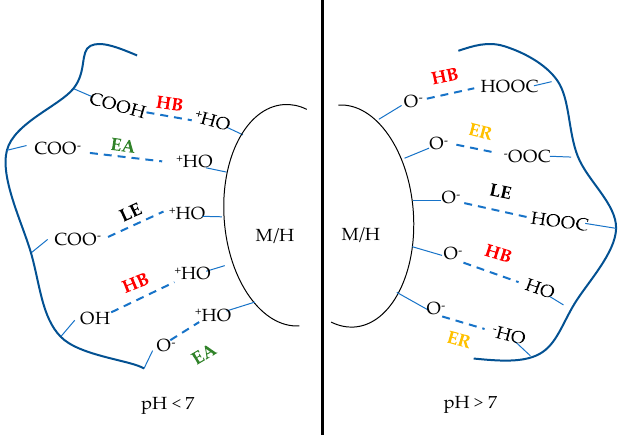
Figure 1. Surface interactions between organic binders and Magnetite(M)/Hematite(H) minerals HB: hydrogen bind, EA: electrostatic attraction; ER: electrostatic repulsion; LE: ligand exchange.